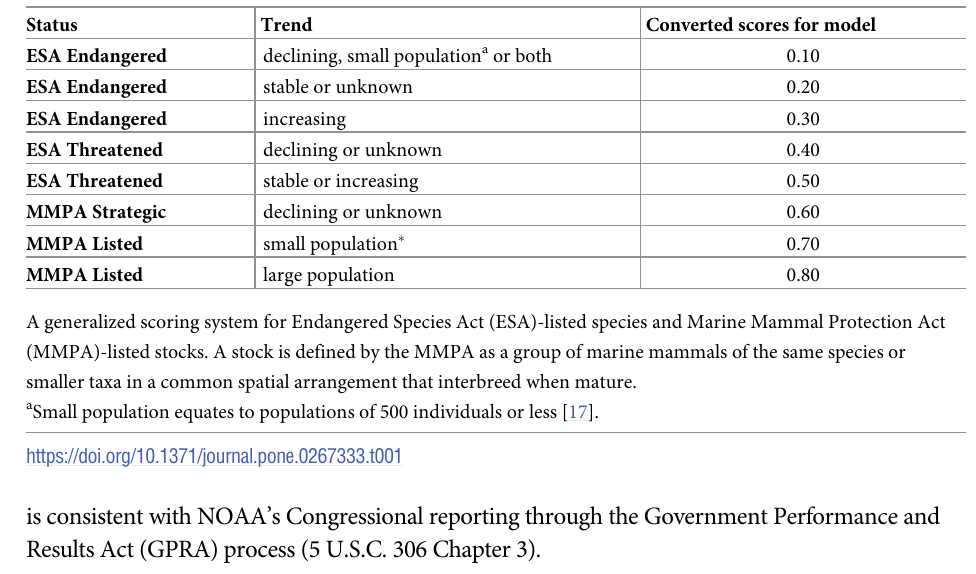
Table 1. Generalized scoring system for protected species.